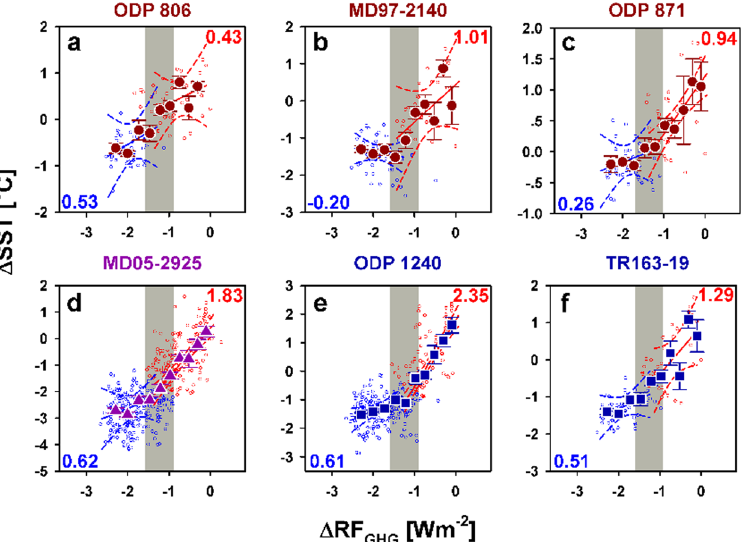
Figure 4. Comparison of tropical Pacific SST sensitivities. ( a–c ) Western Pacific with three sites: ODP 806, MD97-2140, and ODP 871 (refs 4, 9, 10). ( d ) Solomon Sea (site MD05-2925, this study). ( e , f ) Eastern equatorial Pacific with two sites: ODP 1240 and TR163-19 (refs 9, 11). Symbols, lines, slopes, and gray vertical bars are the same as in Figure 3 but for multiple sites. The data from three G/IG cycles are used in ( e ), and data from four G/ IG cycles are used in the other